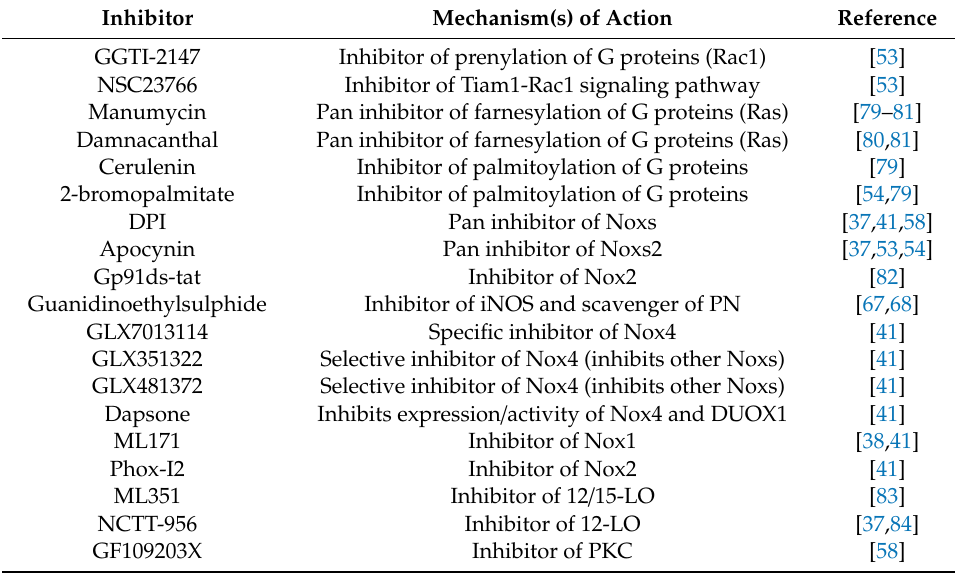
Table 1. Inhibitors of the Nox, iNOS, and 12-LO signaling pathways employed in studies highlighted in this